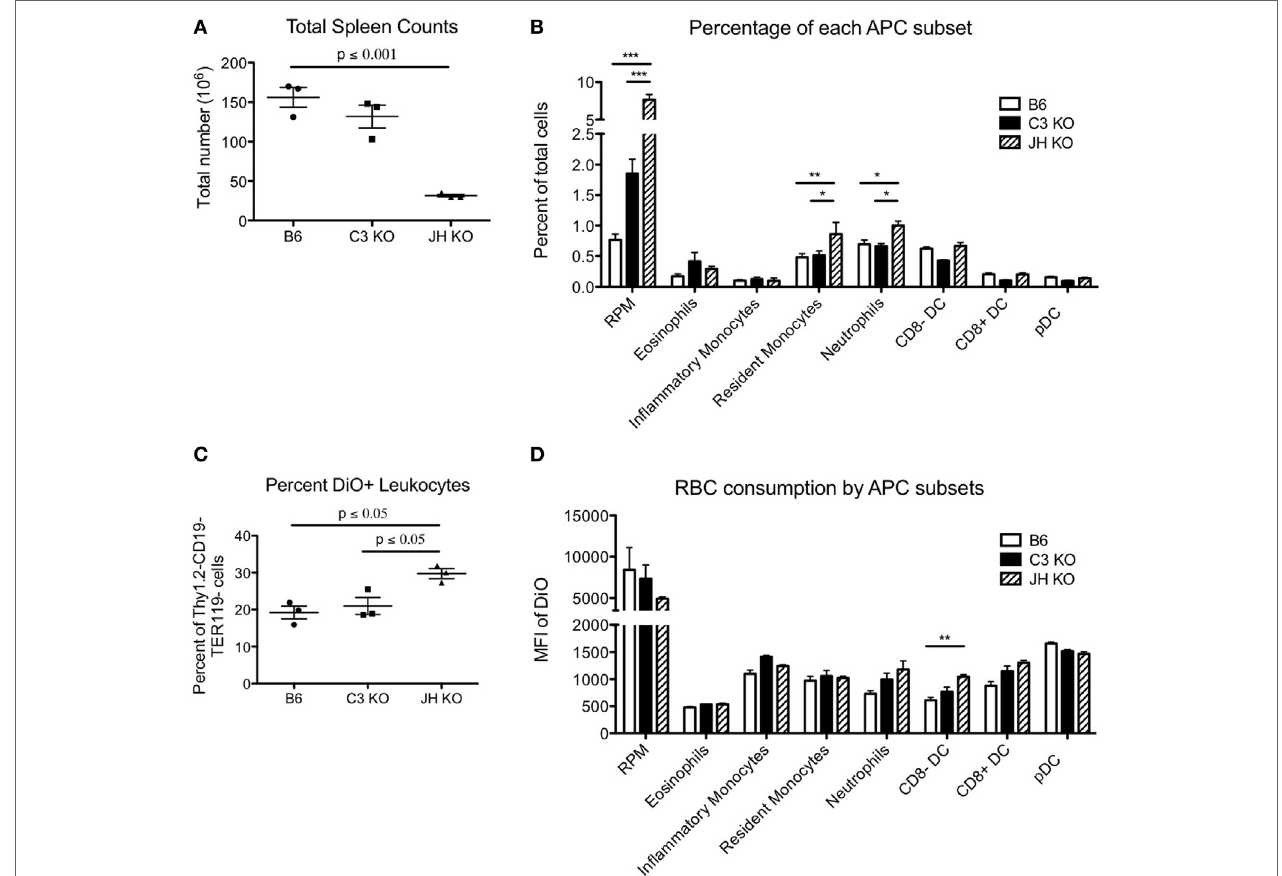
FigUre 2 | Consumption of red blood cells (RBCs) by different phagocytic subsets. RBCs were labeled with DiO + and transfused into the indicated recipient strains. Subsets of recipient splenocytes were enumerated by flow cytometry using standard staining panels for lineage specific antigens (a,B) . The extent of RBC consumption was assessed by gating on each indicated lineage and assessing DiO fluorescence, which reflects the extent of RBC consumption (8) (c,D) . Only events that stained negative with anti-TER119 (an RBC specific antigen in mice) were counted, so as to avoid evaluating phagocytes with RBCs stuck to the surface, as opposed to consumed. Representative data are shown for one experiment with three mice per group. Similar results were obtained in three out of three repetitions. For cellular subset analysis, T cells, B cells, and RBCs were excluded from total live leukocytes by gating on Thy1.2 − CD19 − TER119 − cells. Red pulp macrophages (RPM) are defined as CD11c int F480 + CD11b lo/ − , CD8a − dendritic cells (DCs) express CD11c hi CD11b + CD8a − whereas CD8a + DCs are CD11c hi CD11b − CD8a + , and plasmacytoid DCs (pDCs) are CD11c int Ly6C hiL Ly6G − B220 + . CD11c int/ − CD11b + Ly6G − Ly6C hi CD115 + inflammatory